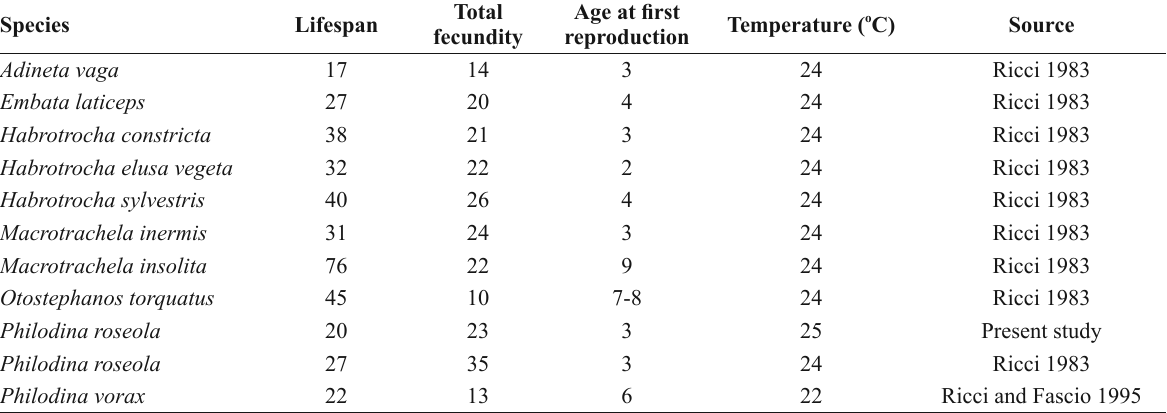
Comparison between lifespan (days), total fecundity, age at fi rst reproduction and culture temperature of Philodina roseola , observed in this study, and variables taken from the literature for 19 rotifer